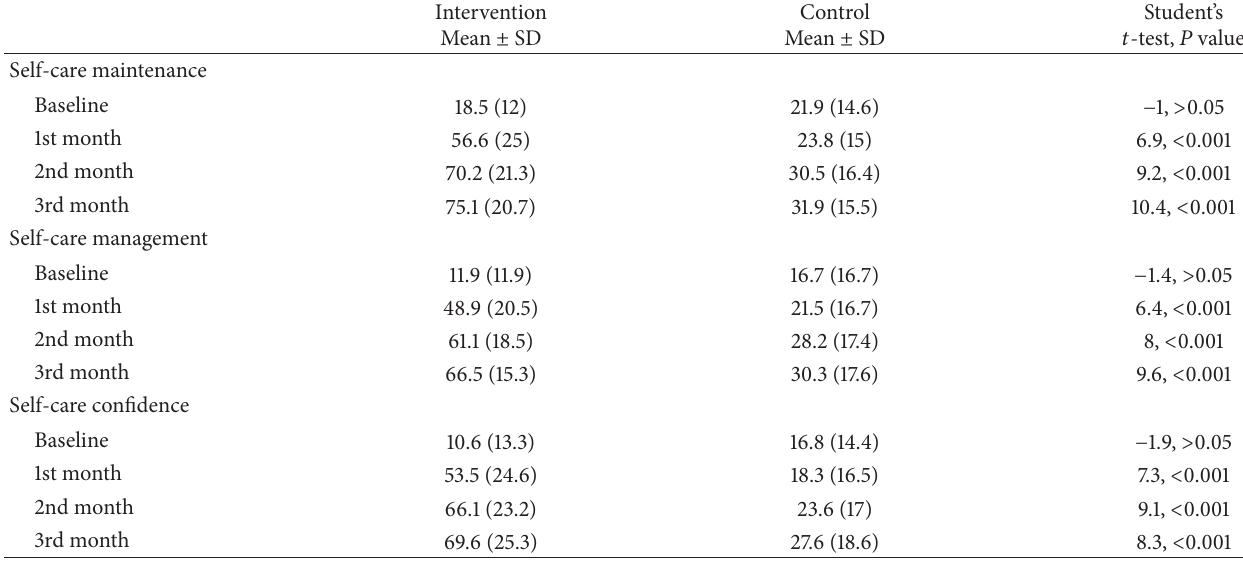
Table 2: Comparison of self-care scores (maintenance, management, and confidence) by group and time.